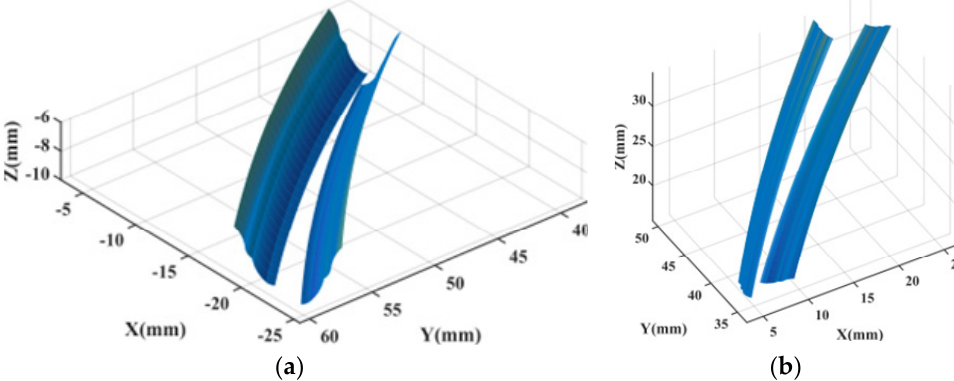
Figure 7. Double-arc tooth profiles: ( a ) The tooth profile of a crown gear. ( b ) The tooth profile of internal spiral bevel gear.